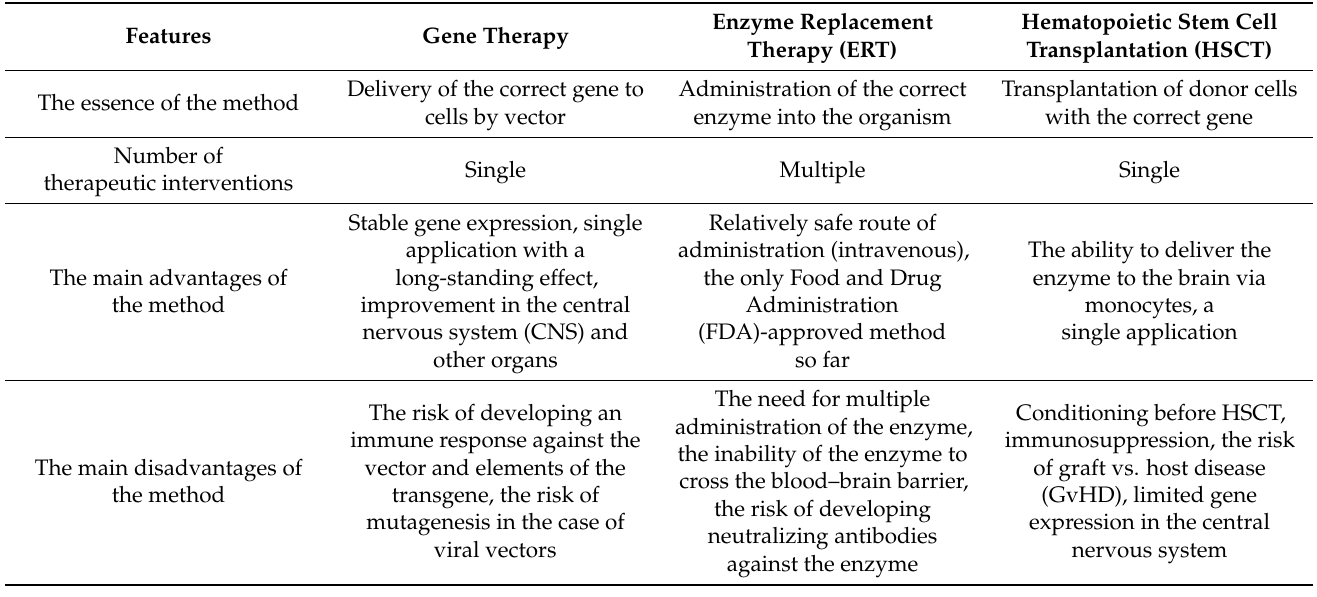
Table 1. Comparison of enzyme replacement therapy, gene therapy, and hematopoietic stem cell transplantation.